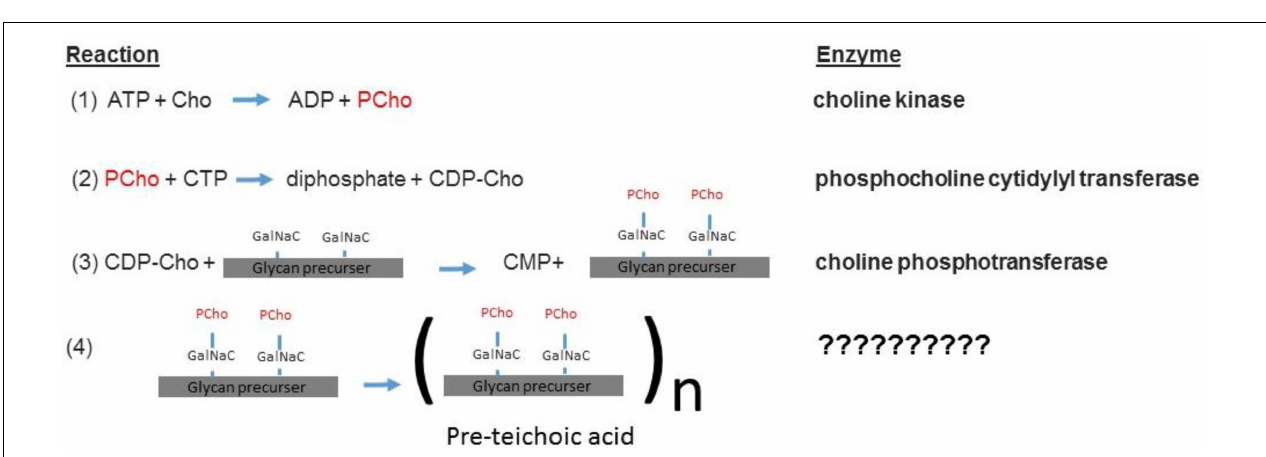
FIGURE 3 | Taxonomy of prokaryotic species containing a ChoK gene that is highly conserved with respect to sChoK.